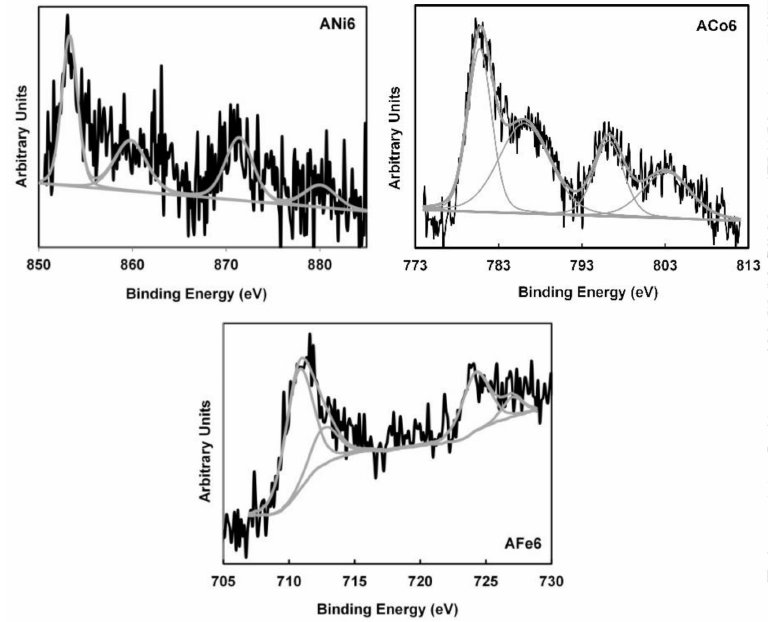
Figure 6. XP spectra of the doped carbon